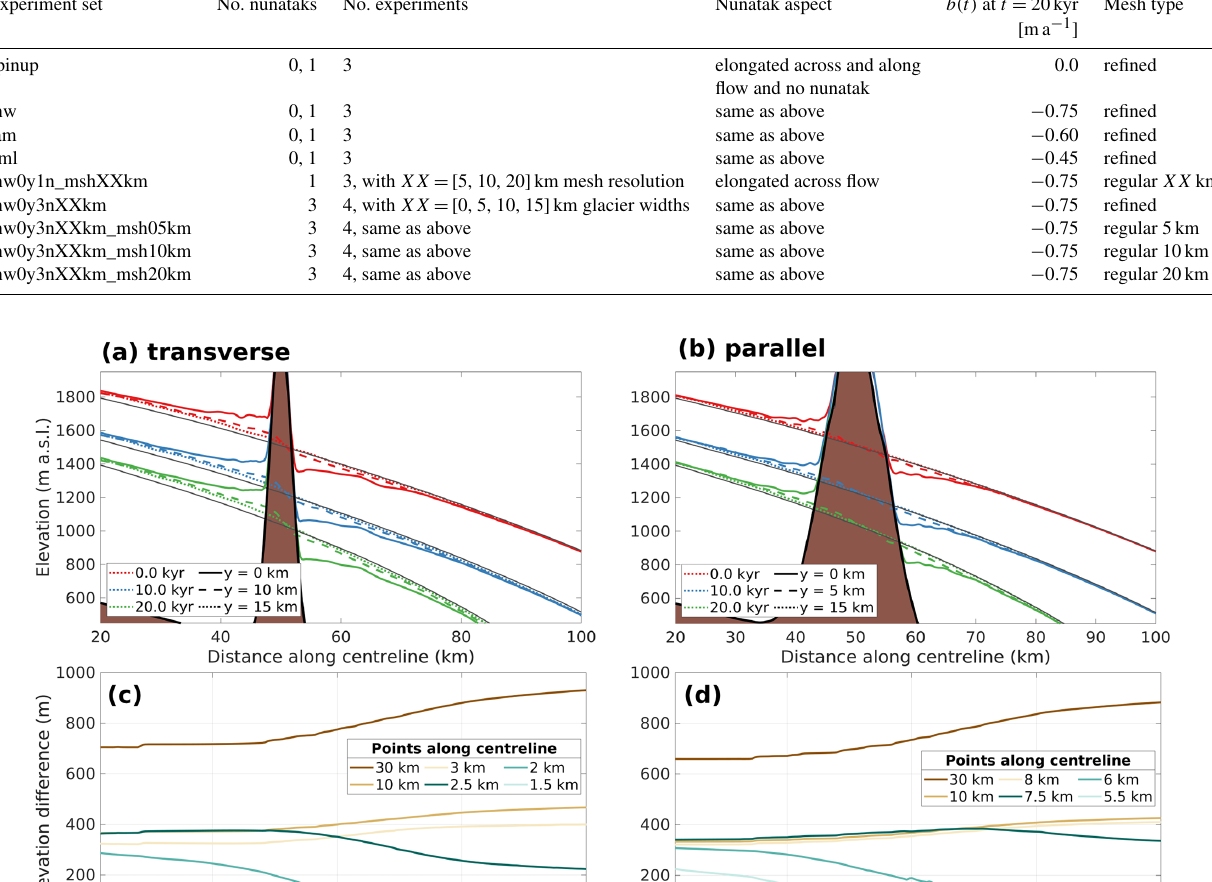
Table 2. Summary of the experiments performed in this study. Adaptive mesh experiments are those that have a mesh refinement of up to 205m around nunataks and the grounding line. Regular-mesh experiments have no refinement anywhere in the domain. Experiment set